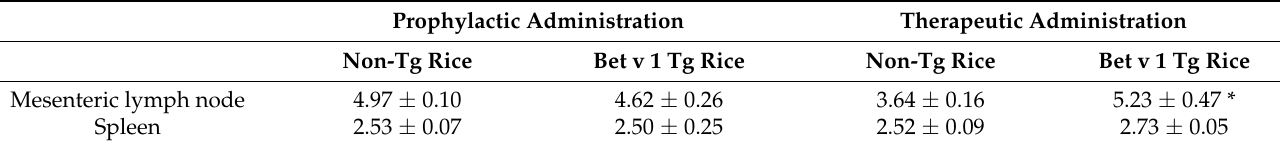
Prophylactic Administration